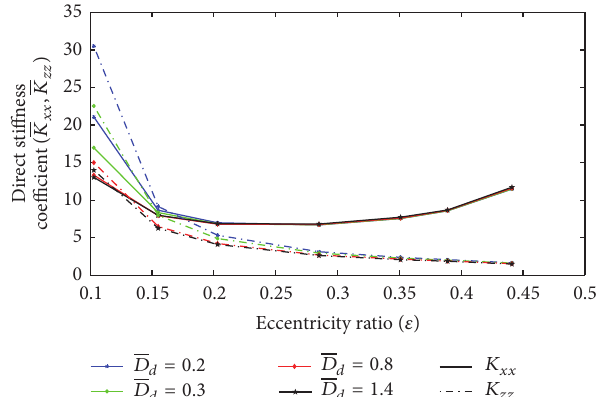
Figure 19: Effect of dam depth ratio on direct stiffness coefficient.